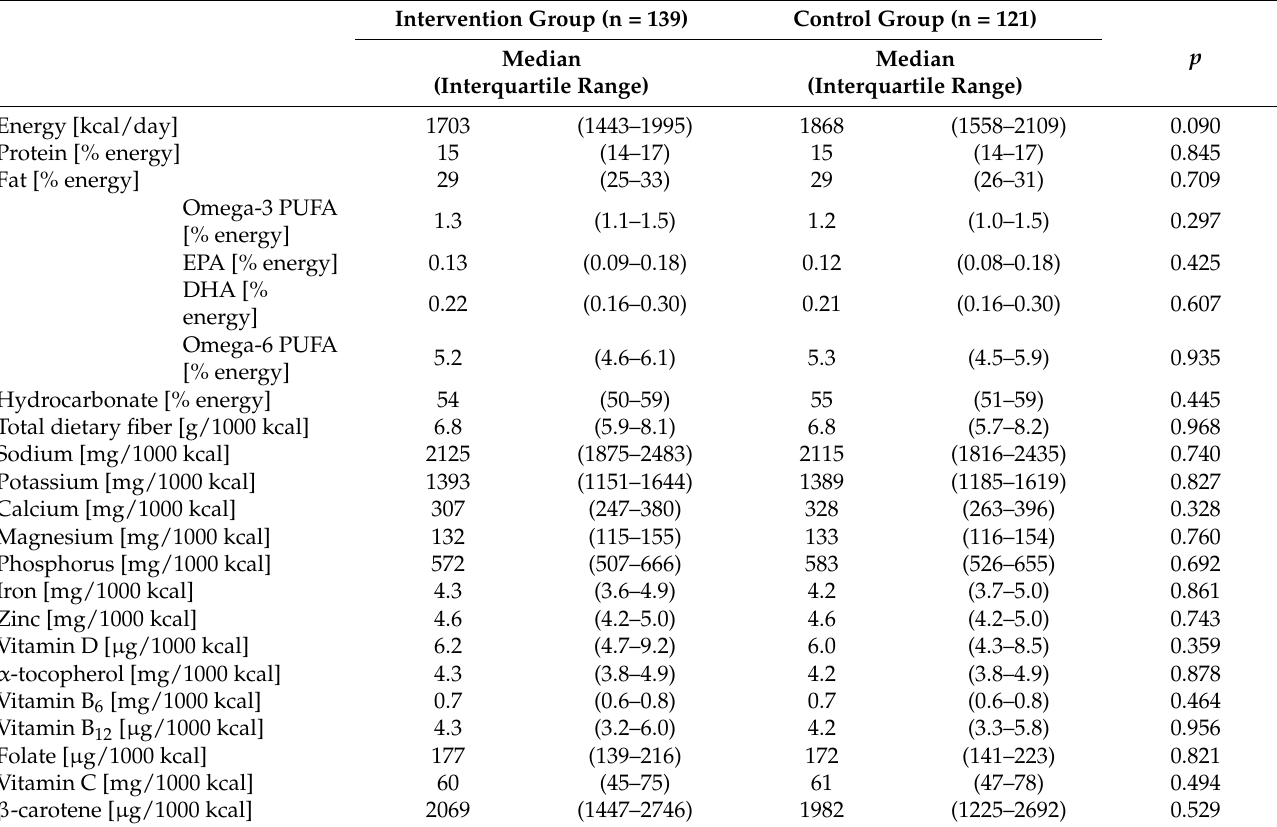
Table 2. Nutrient intake at 1 month postpartum.